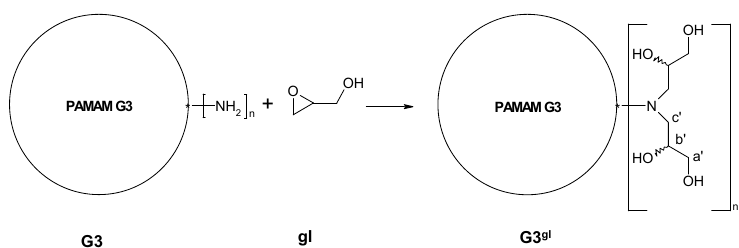
assigned by COSY experiment.